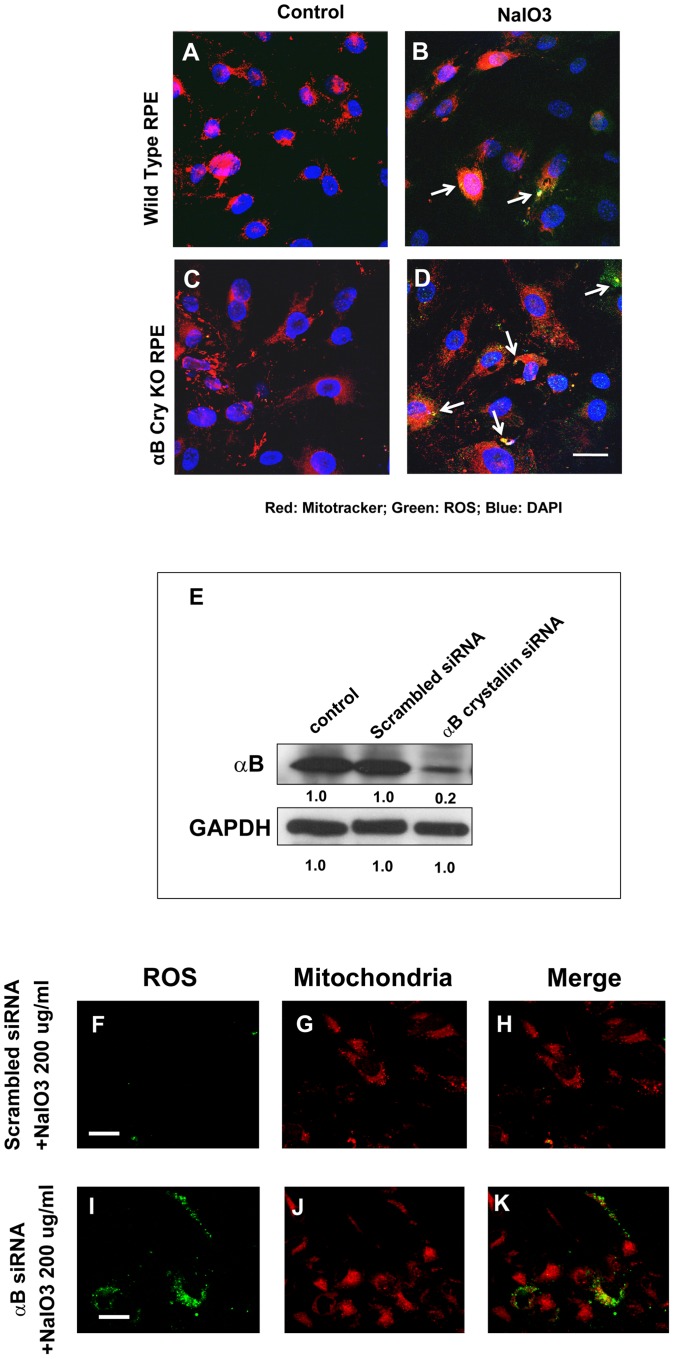
Increased production of reactive oxygen species (ROS) in mouse primary RPE cells and human RPE cells transfected with αB crystallin (αB-/-) siRNA after NaIO3 treatment.Confluent mouse RPE cells from αB-/- and WT mice were treated with 200 µg/ml NaIO3 for 24 h. In panels A–D, DAPI is shown in blue, ROS staining in green and mitotracker in red. ROS staining was observed in WT RPE cells treated with NaIO3 (A–B). RPE cells from αB-/- mice (C–D, see white arrows) showed increased accumulation of ROS that partially colocalized with mitochondria. For studies with human RPE cells, αB crystallin was knocked down (∼80%) by siRNA transfection (Fig. 5E). Increased ROS production was observed in αB crystallin si-RNA transfected human RPE cells with NaIO3 as compared to scrambled siRNA transfected cells which showed negligible ROS staining (I–K). (F–H). Scale bars represent 20 µm for A–D and 10 µm for F–K, respectively.